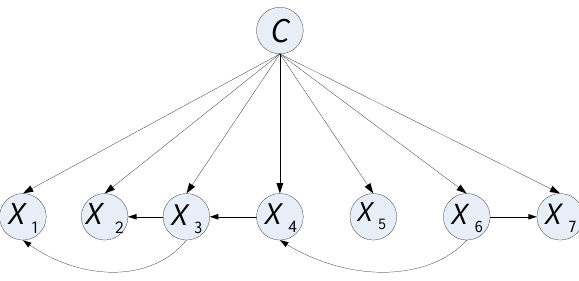
Figure 1. An Example of BAN Applied In the Classification Figure 1 is an example of BAN applied in the classification domain. The node C denotes the class label